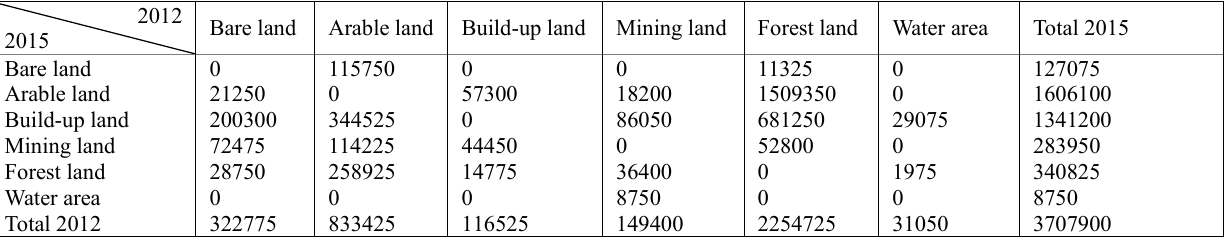
Table 4. The pivottable of changed area from 2012 to